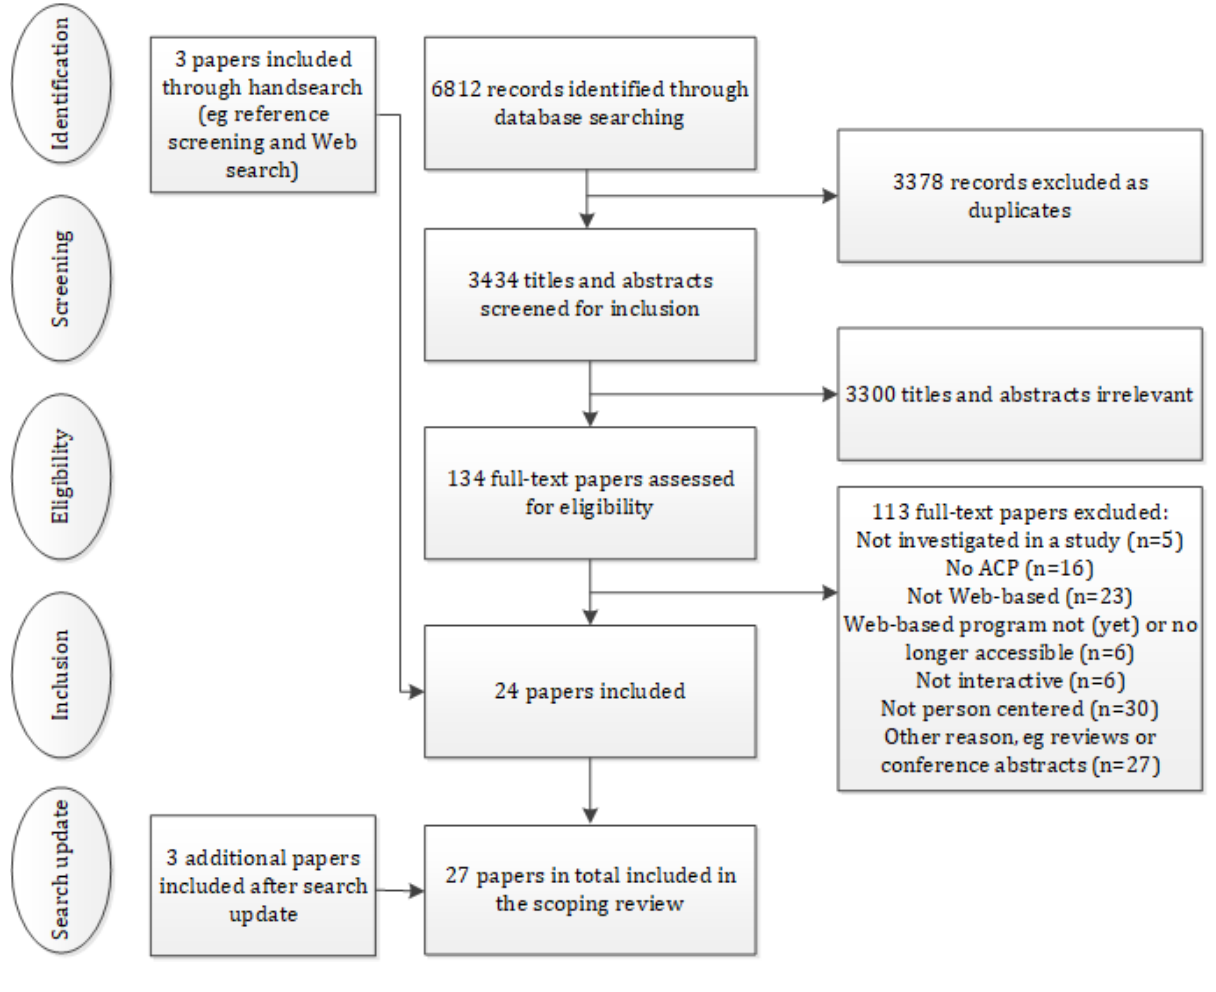
Figure 1. Flowchart of the inclusion of